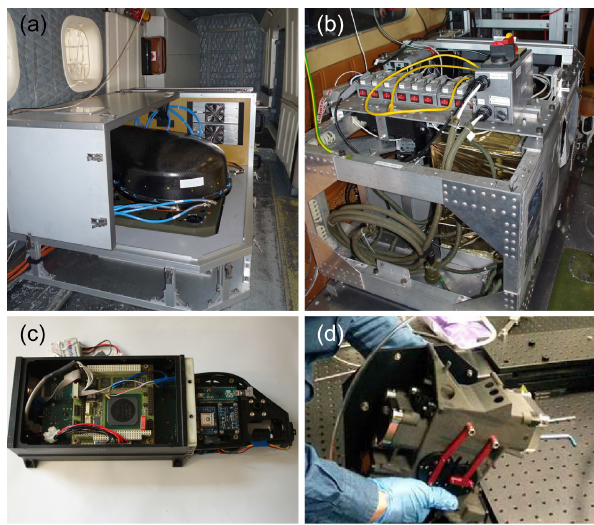
Figure 2. Overview of the four DOAS imaging instruments: APEX (a) , AirMAP (b) , SWING (c) , and SBI (d)